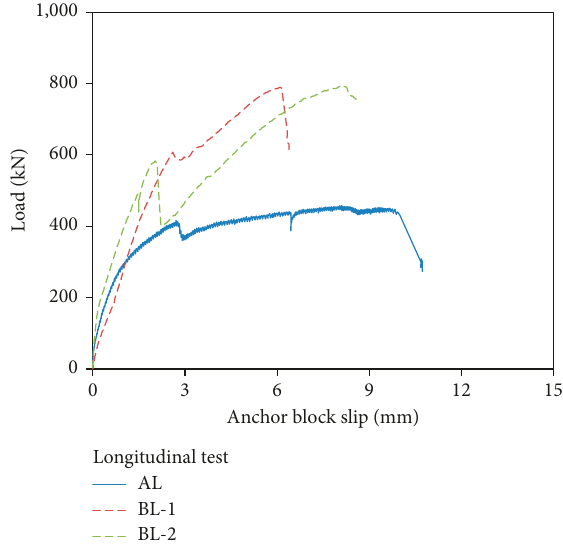
Figure 12: Longitudinal load-anchor block slip